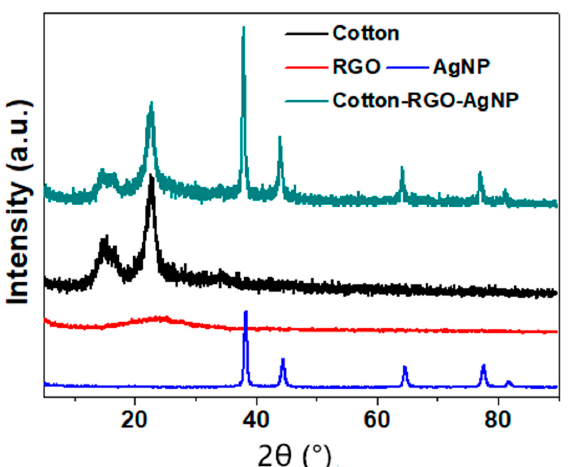
Figure 2. XRD patterns of commercially available cotton thread, RGO powder and AgNPs together with that of the cotton-RGO-AgNP hybrid fiber synthesized in the present work.